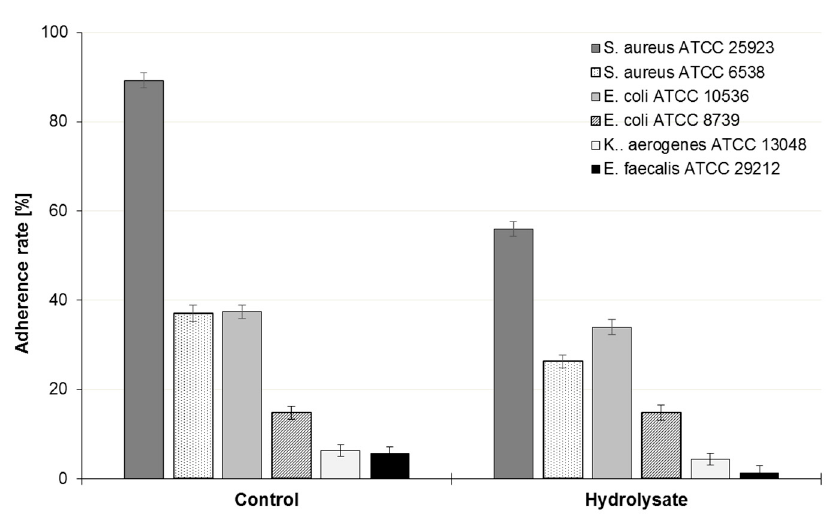
Figure 6. Adherence of pathogenic bacteria to Caco-2 cell line in the presence of SBP hydrolysate relative to the control samples. Error bars denote SD. The data represent means from three replicates in one experiment. The results do not differ significantly from the unexposed controls, ANOVA ( p < 0.05). The SBP hydrolysate inhibited adherence by all tested Candida sp. strains (Figure 7). The inhibition rate was the strongest for C. albicans ATCC 10231 (98.5%, p < 0.05), while it was the weakest for C. utilis ŁOCK0021 (7.8%) (Table 1). For C. lusitanie ŁOCK 0004 and C. pelliculosa ŁOCK 0007, the inhibition rates were 77.1% and 52.5%,